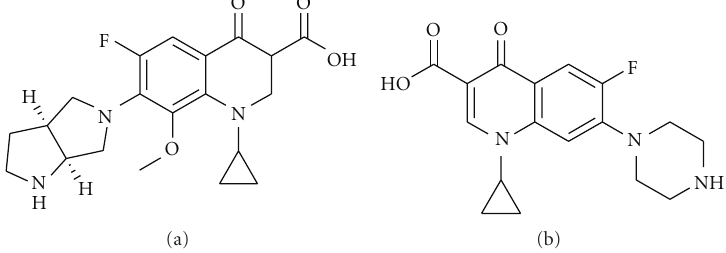
Figure 1: Chemical structures of the fluoroquinolones: (a) moxifloxacin (1-cyclopropyl-6-fluoro-1,4-dihydro-8-methoxy-7-[(4aS.7aS)- octahydro-6H-pyrrolo-[3,4-b]pyridin-6-yl]-4-oxo-3-quinolinecarboxylic acid hydrochloride, BAY 12-8039); (b) ciprofloxacin (internal